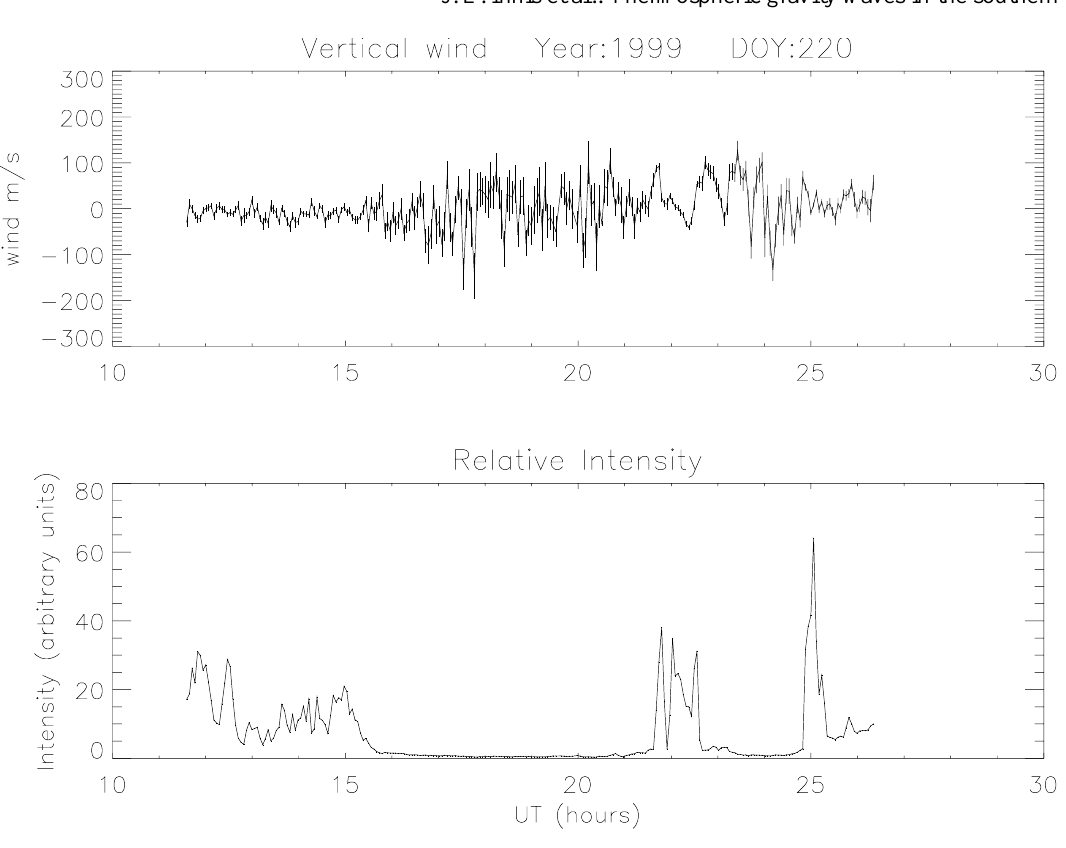
Fig. 4. FPS λ 630 nm data of wind and relative intensity from DoY